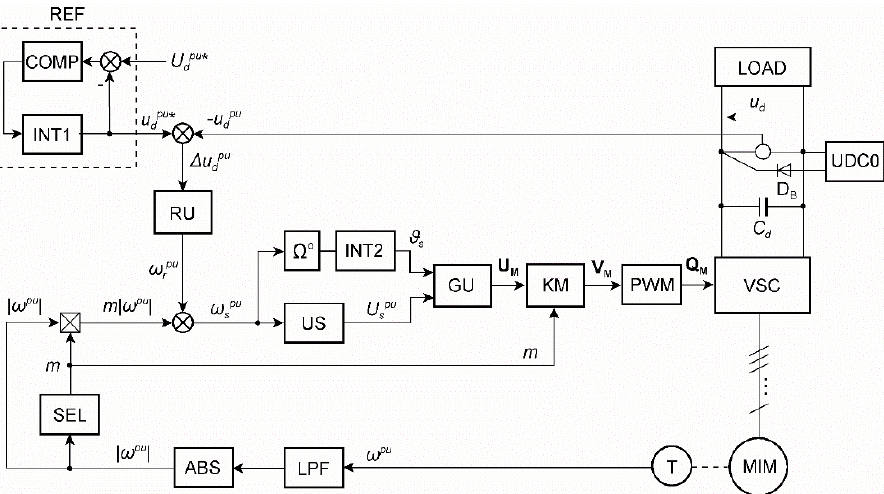
Figure 10. Structure of the control system: REF — voltage reference network shaping u dpu* as the ramp signal, COMP — comparator, INT1 — signal ramp integrator, RU — voltage controller, US — generator of voltage signal U spu dependent on ω spu , INT2 — integrator of stator frequency, GU — generator of M phase control signals, KM — switch of control signals sequence, PWM — pulse width modulator, VSC — voltage source converter, LPF — low-pass filter, ABS — absolute value changer, SEL — selector of supply sequence number m with respect of the MIM speed signal ω pu .